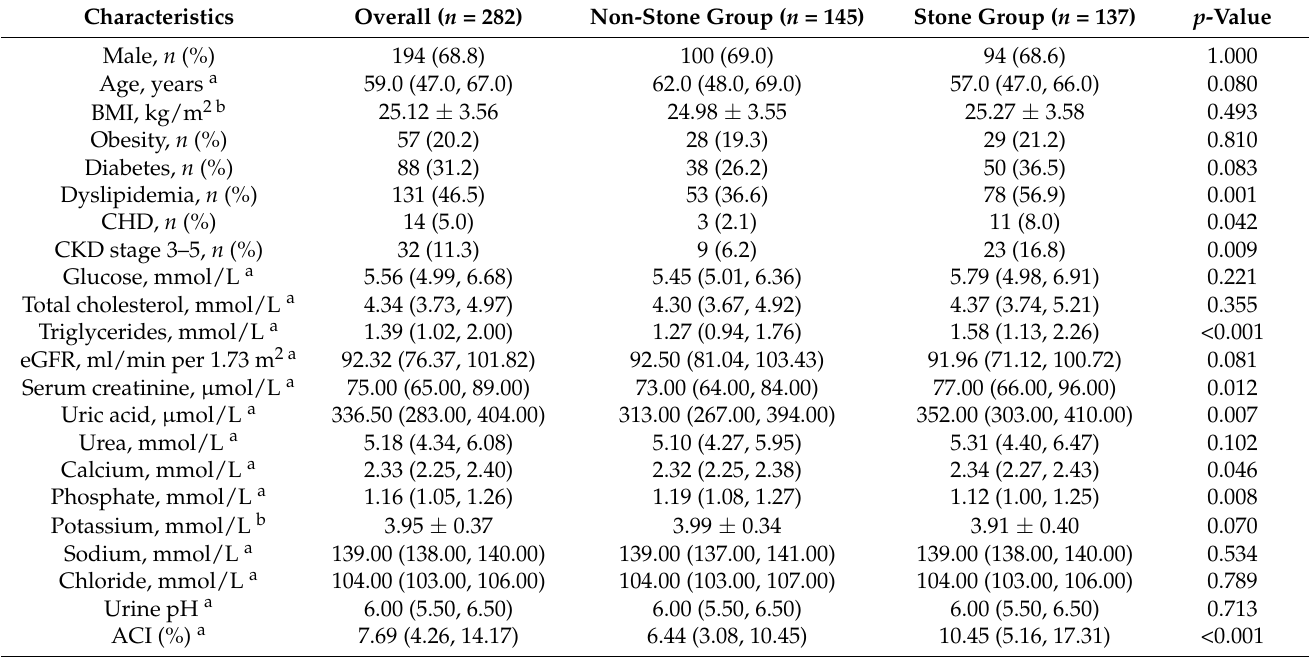
Table 1. Characteristics of the study